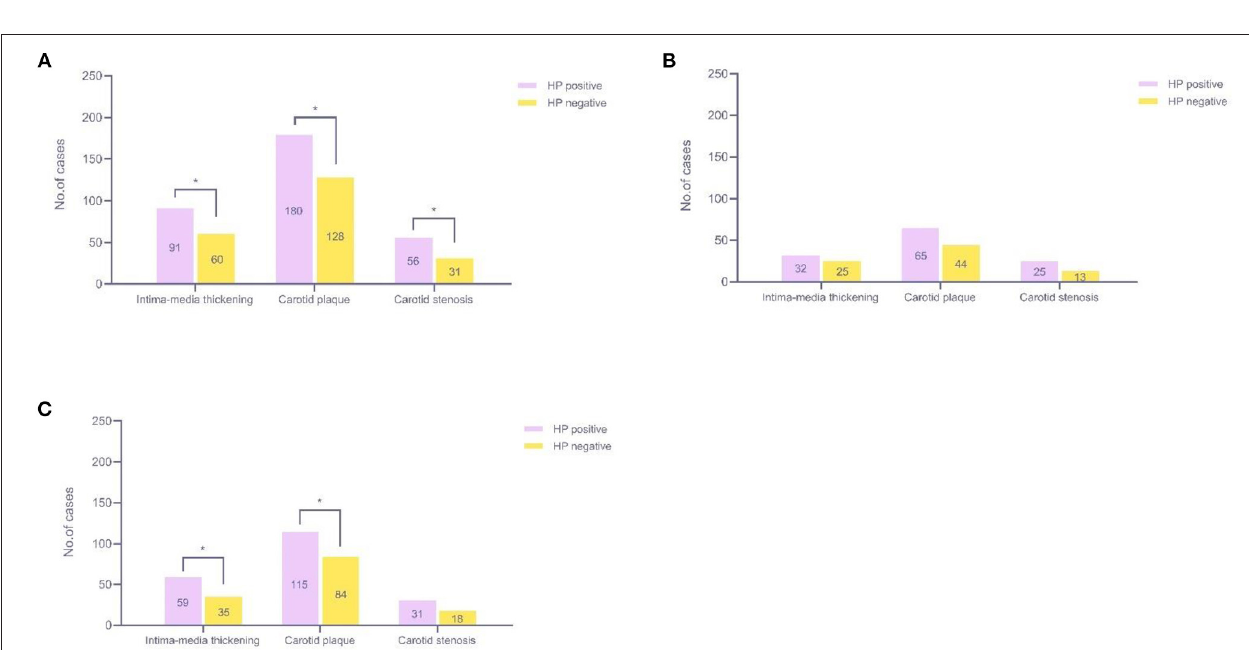
FIGURE 4 | CAS risk prediction model. Variable definition. Sex: 1 = male, 2 = female; HP infection: 0 = negative, 1 = positive; Metabolic syndrome: 0 = no, 1 = yes; Excessive salt intake: 0 = no, 1 = yes; Smoking: 0 = no, 1 = yes. CAS, carotid atherosclerosis; HP, Helicobacter pylori .